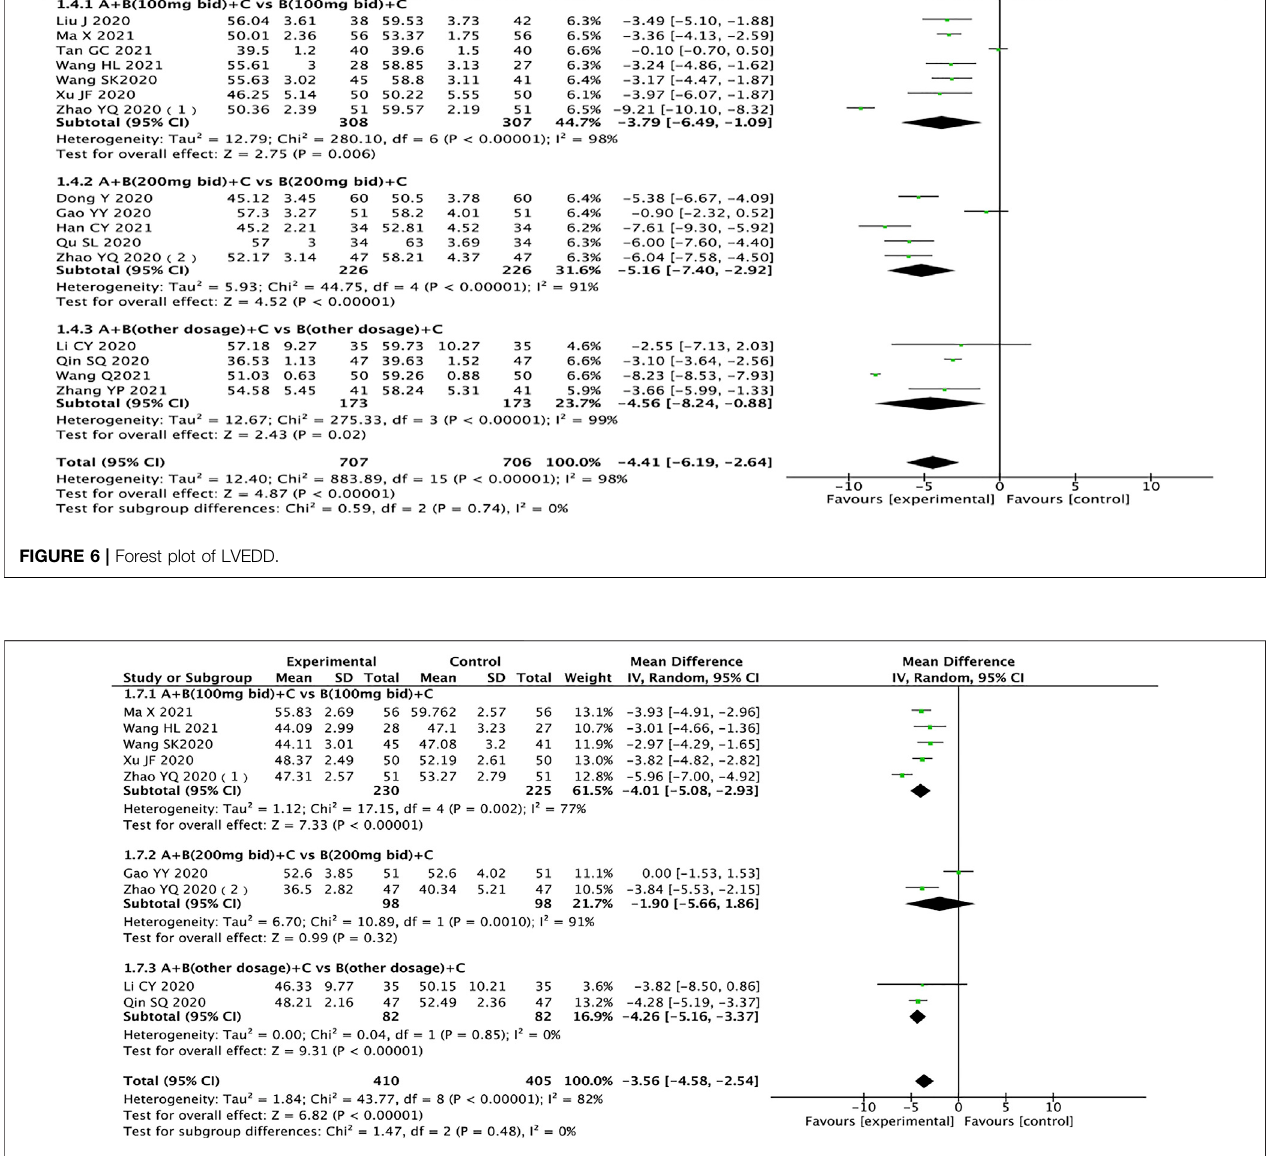
FIGURE 7 | Forest plot of